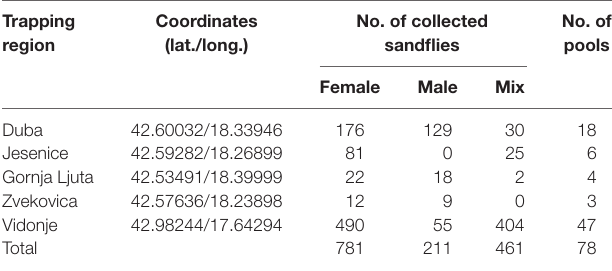
tabLe 1 | Sandfly trapping regions and number of the collected sandflies. trapping Coordinates region